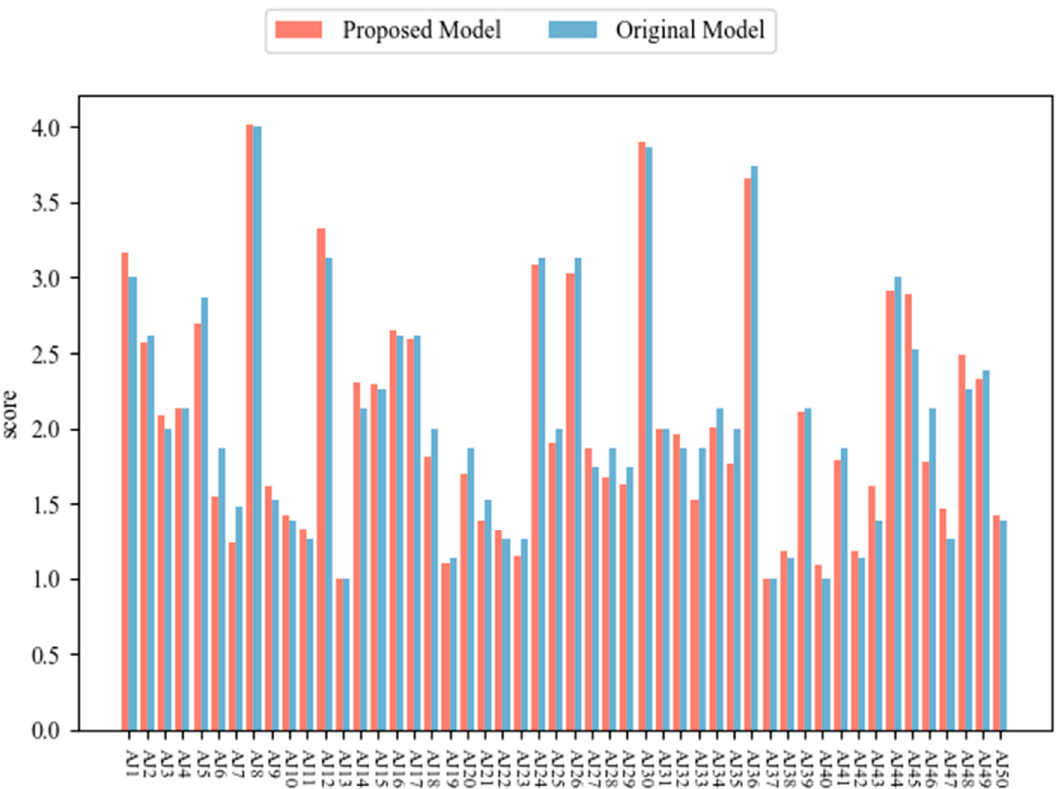
Figure 11. Comparison of evaluation results of different models.